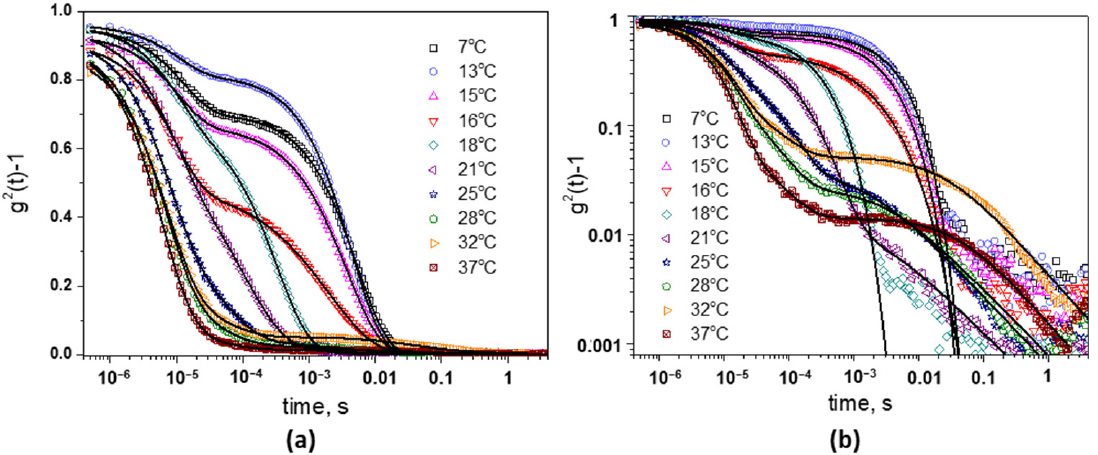
Figure 9. Intensity autocorrelation functions for 17% aqueous Poloxamer 407 solution at different temperatures measured at scattering angle of θ = 173 ◦ : g 2 (t) − 1 vs. log(t) representation ( a ), and log − log representation ( b ). The lines are the fits with Equations (4) and (5).